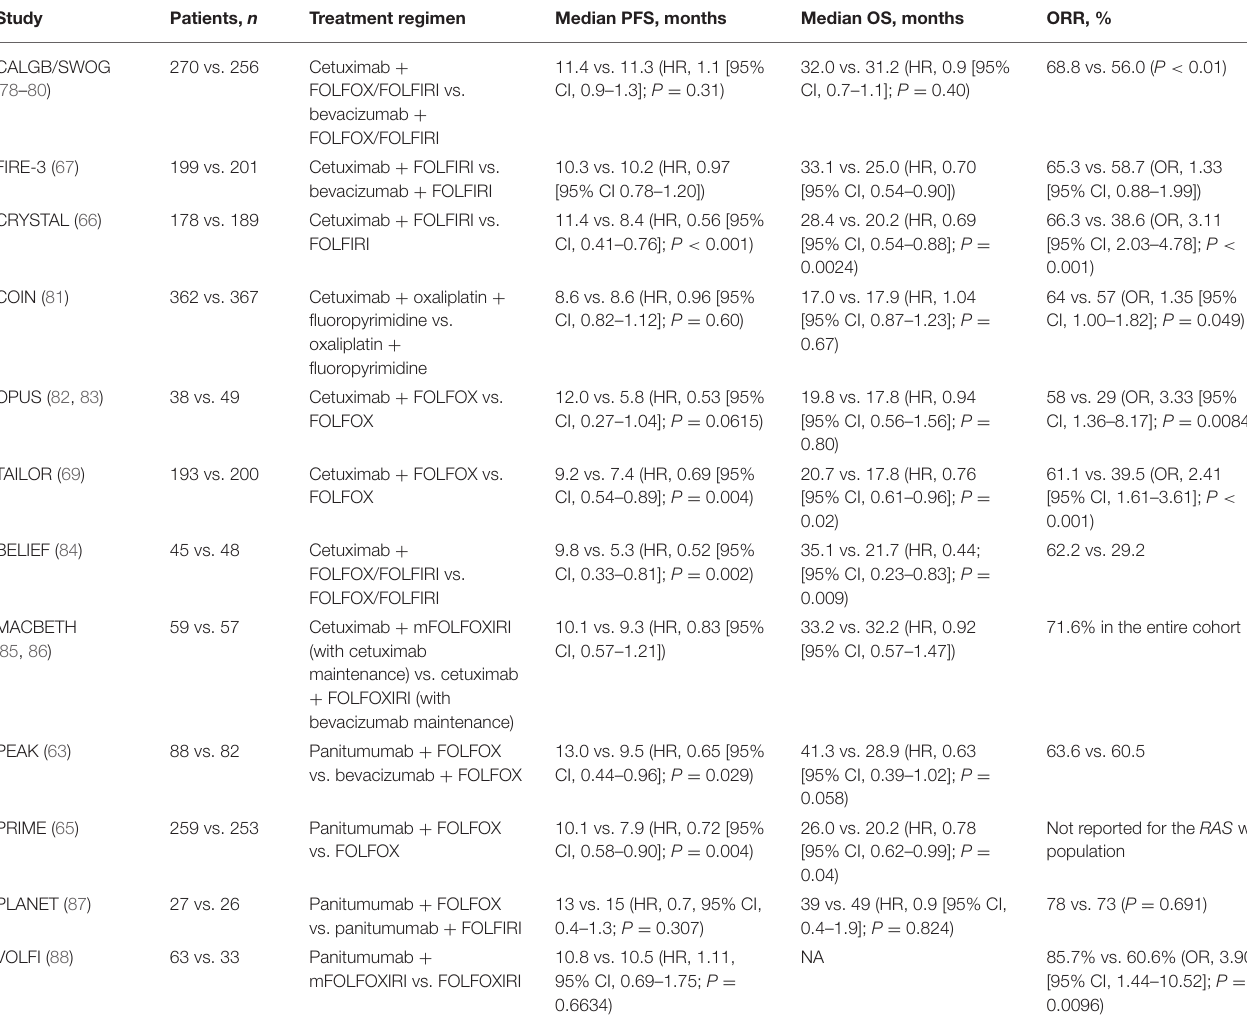
TABLE 3 | Clinical impact of cetuximab and panitumumab in RAS wt mCRC * .